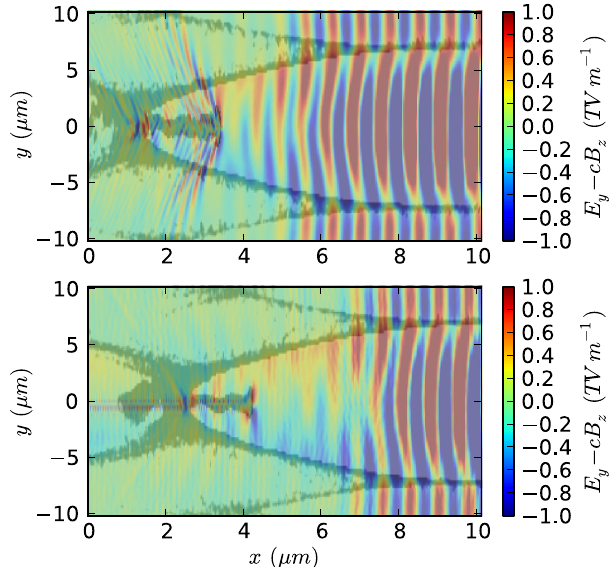
(cid:1) cB in the x - y y z